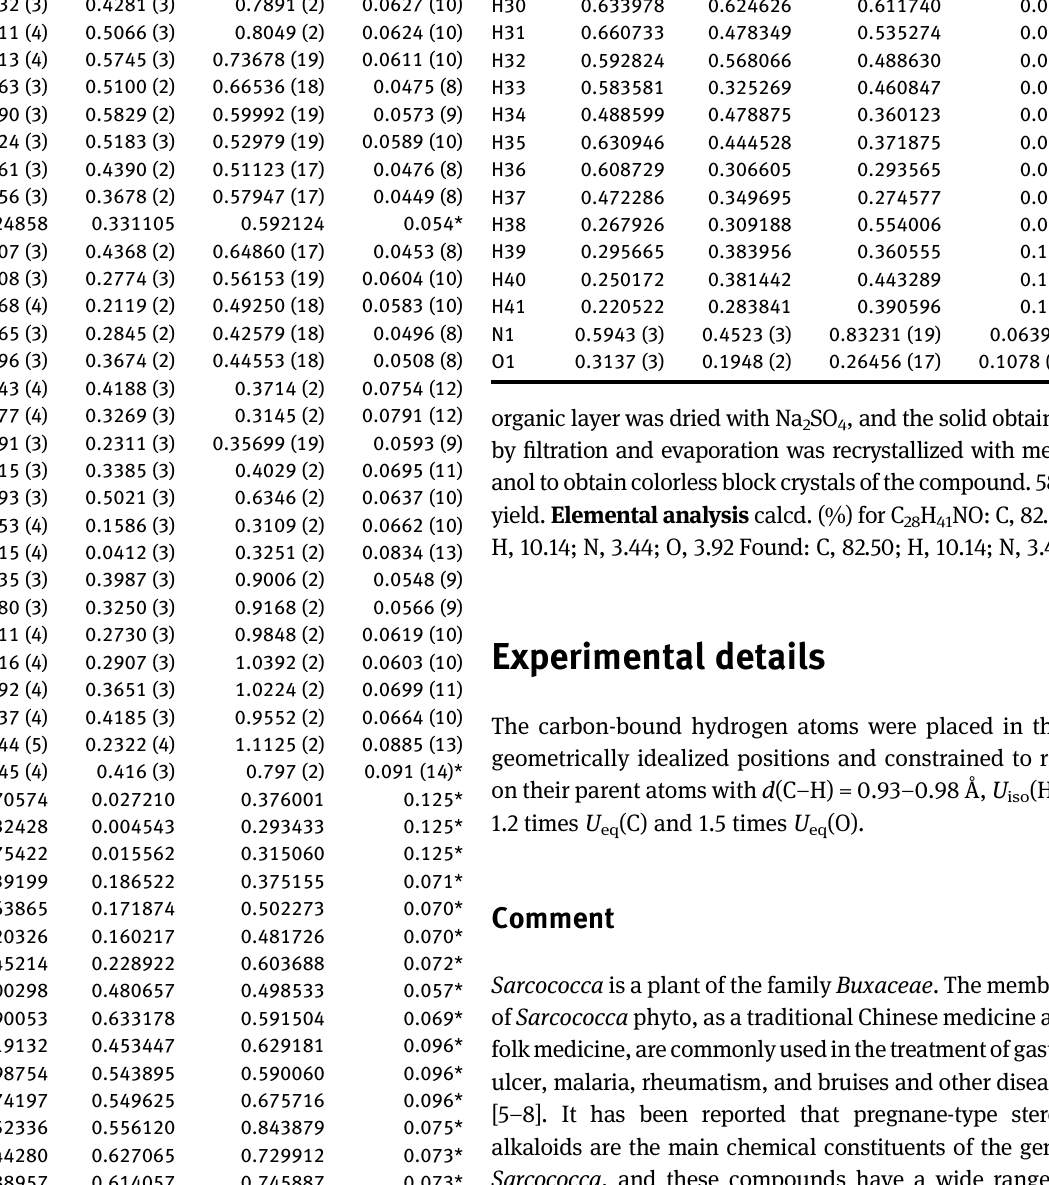
SO , and the solid obtained 2 4 H NO: C, 82.50; 28 41